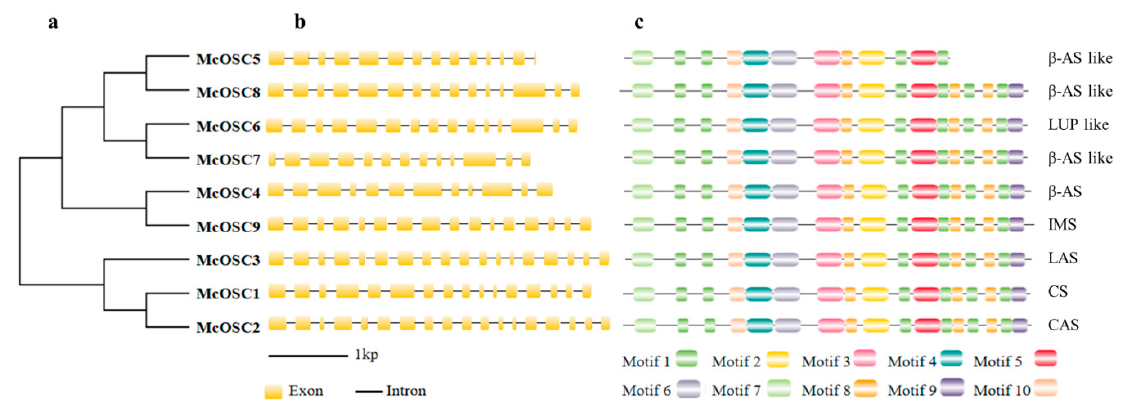
Figure 1. Phylogenetic, exon–intron structure, and motif analysis among nine McOSCs. ( a ) Phylogenetic relationships among nine McOSC proteins; ( b ) exon–intron structure analysis among nine McOSC genes; ( c ) motif analysis among nine McOSC proteins. Types of OSCs are β -AS: β -amyrin synthase; LUP: lupeol synthase; IMS: isomultiflorenol synthase; LAS: lanosterol synthase; CS: cucurbitadienol synthase; CAS: cycloartenol synthase.